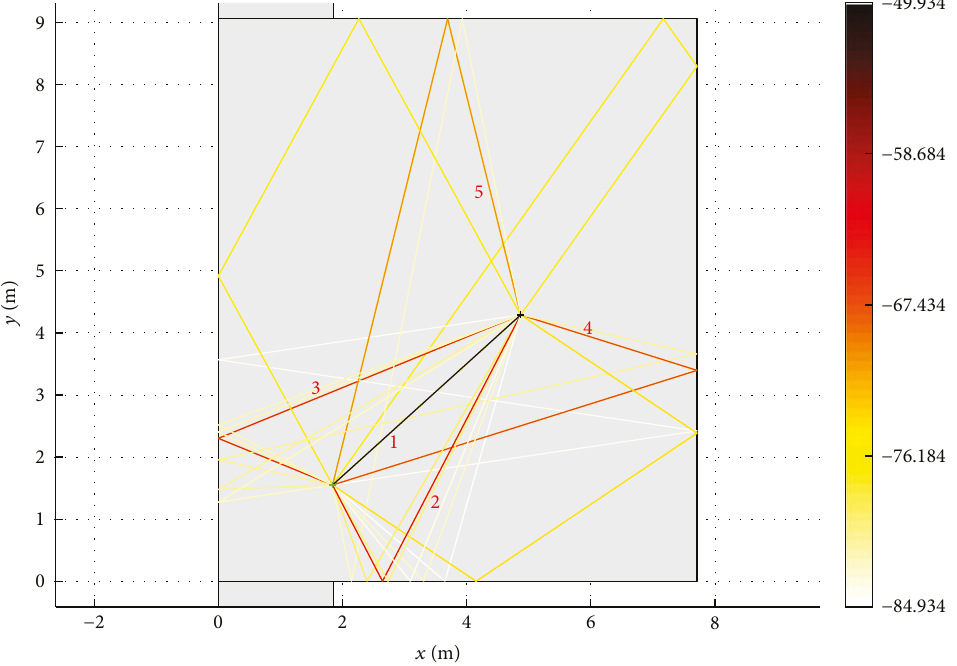
Figure 10: Ray trajectories of the multipath components for Tx position 4 in the basement